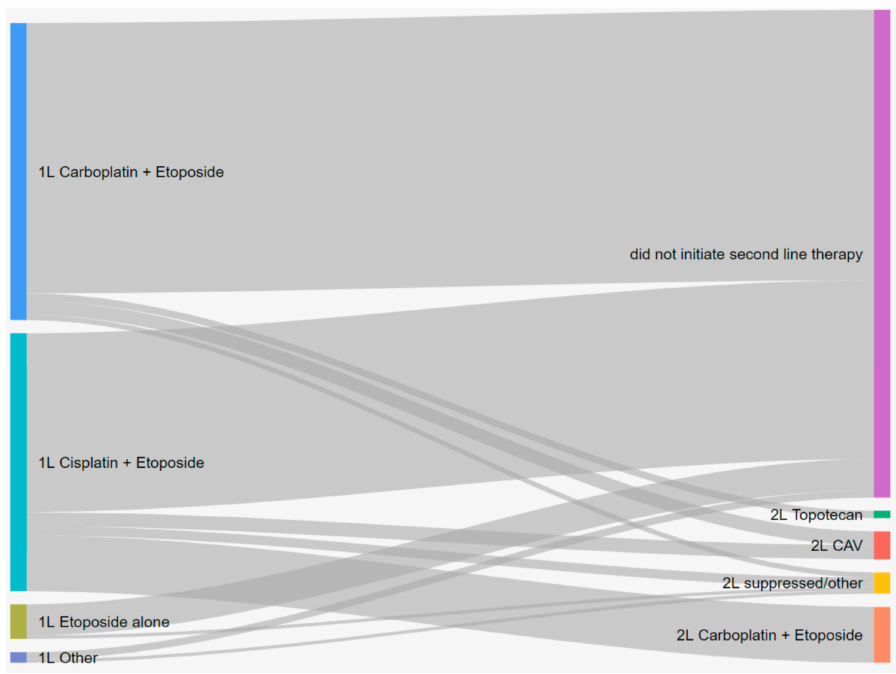
Figure 1. Treatment patterns of ES-SCLC patient in Alberta, Canada, from first-line to second-line